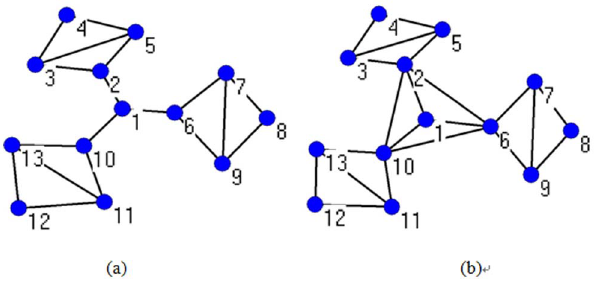
Figure 4. Comparisons of the value between the betweenness and bridge role in two identical networks. (a) N =13 and M =12. (b) N =13 and M =16. Node 1 is also in the center in these two networks as shown in Figure